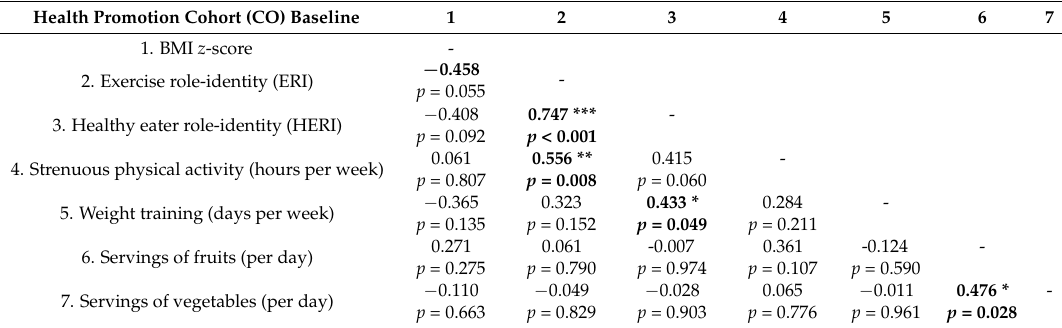
Table 4. Pearson coefficient and p value of select variables demonstrating baseline correlations between ERI and HERI (positive; strong), strenuous physical activity and HERI (positive; moderate), and weight training and HERI (positive; moderate) in the health promotion